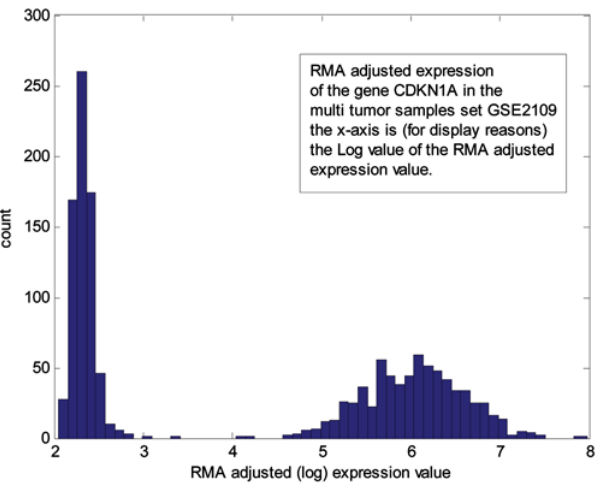
Figure 1. An example to the distribution of gene expression and its resemblance to a mixture of two Gamma distributions. The Up/Down calls for gene states are based on an expression value classified as residing in one of the two distinct